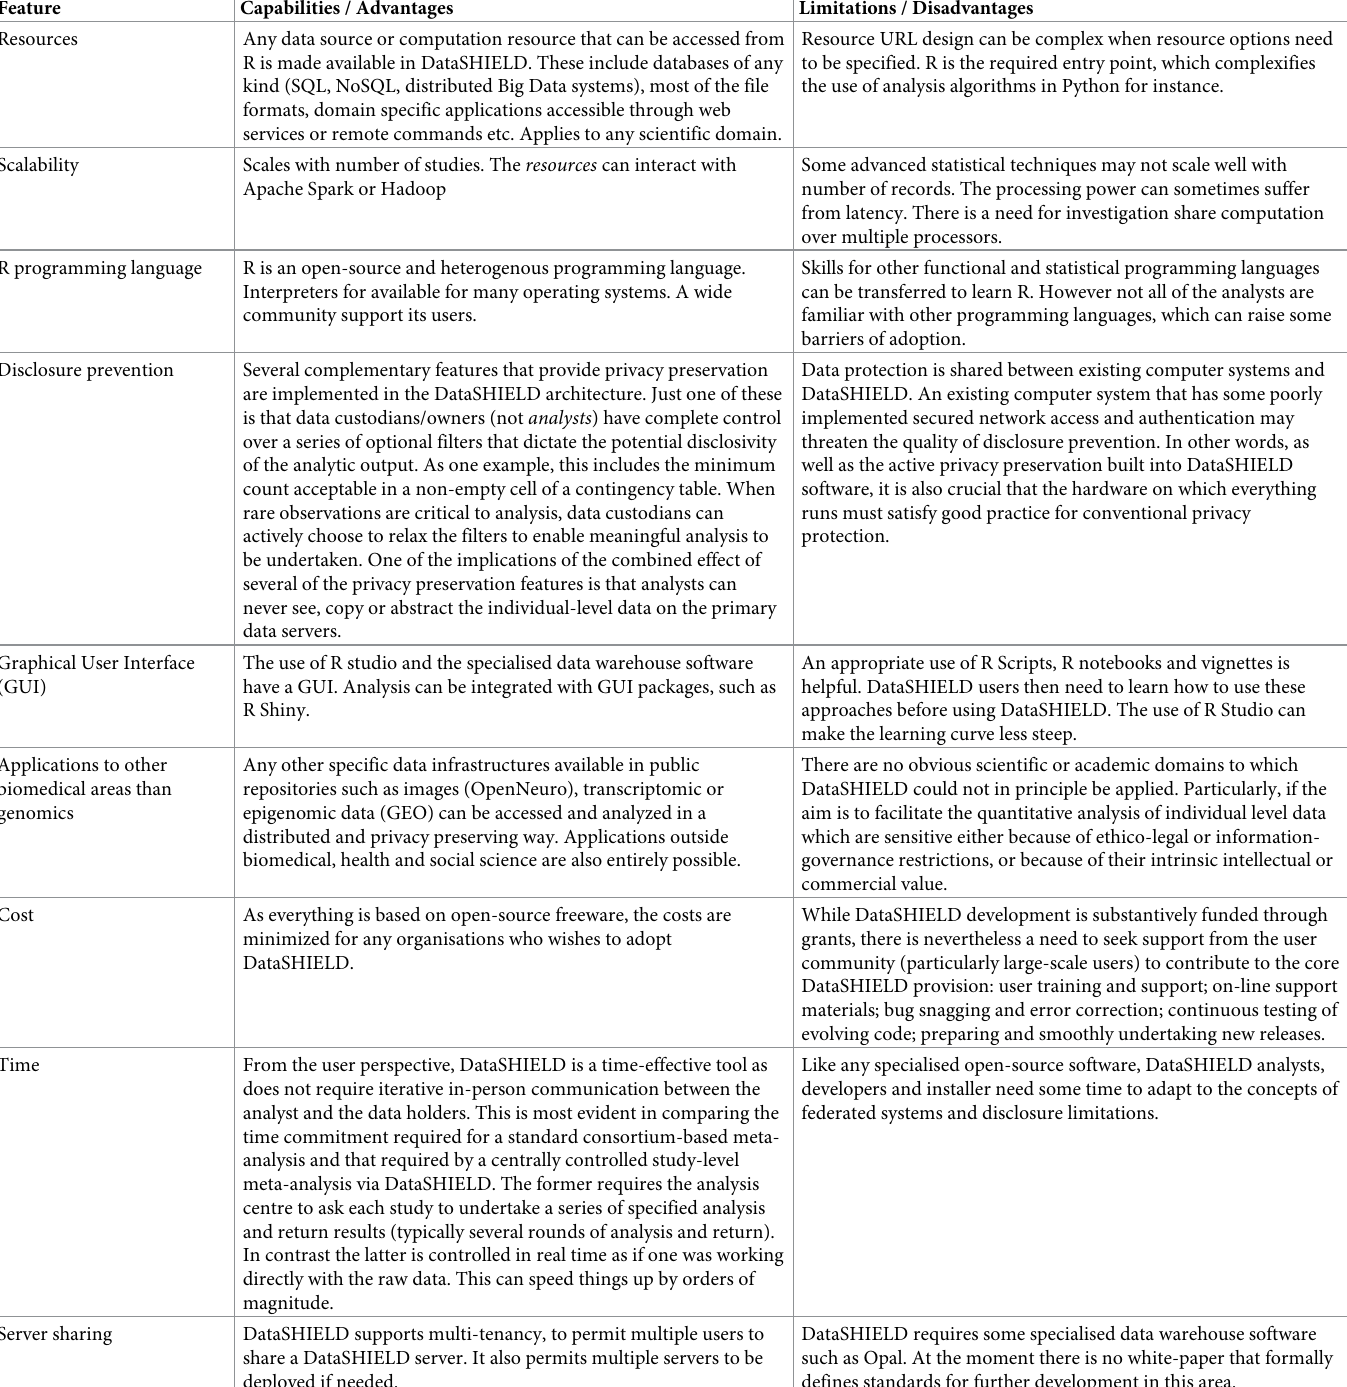
Table 1. Main characteristics of the proposed infrastructure for privacy-protected federated data analyses with big